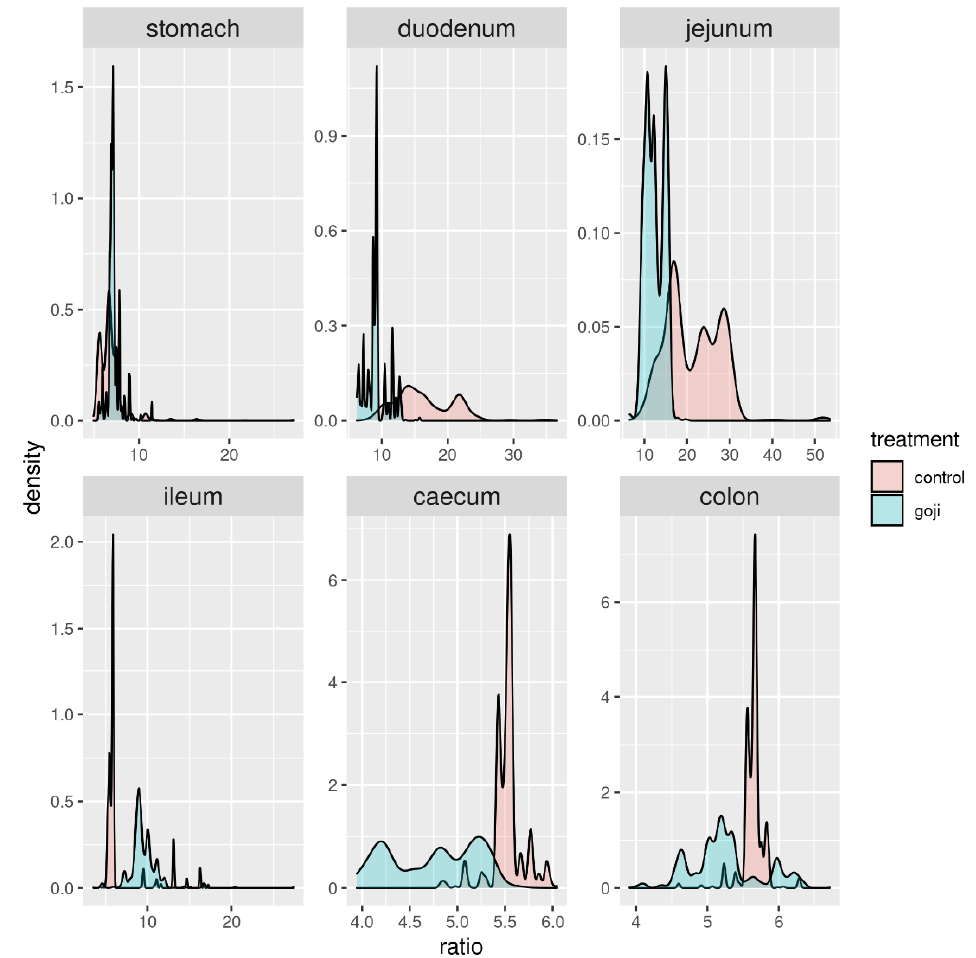
Figure 5. Distribution of the F:B ratio (x-axis) along the digestive tract in Goji-treated (blue) and control (red) rabbits from 1000 bootstrapping replicates of the data. For the analyses, 14 and 13 samples were used for the control and Goji groups, respectively.